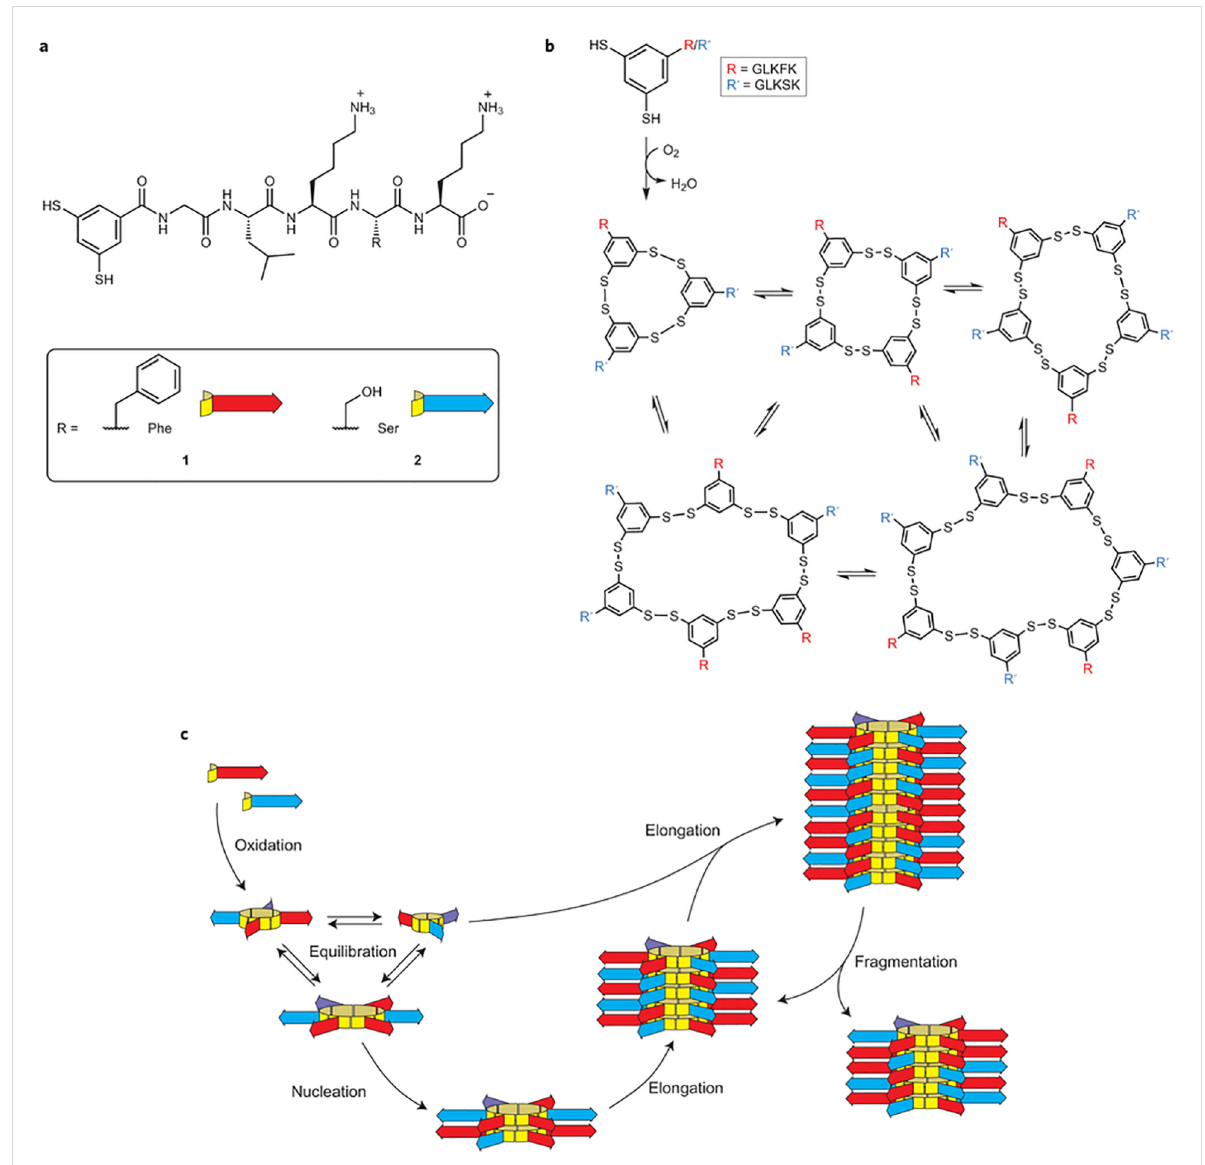
Figure 12: Figure depicting (a) building blocks consisting of a peptide attached to an aromatic ring. Building blocks 1 and 2 differ only in the nature of the penultimate amino acid. (b) The building blocks can form macrocycles of different sizes upon oxidation, which can exchange building blocks with each other. (c) Schematic representation showing how building blocks oxidize to form macrocycles that in turn form stacks due to β -sheet formation. Stacks grow from their ends and fragment upon agitation, leading to more fiber ends and faster growth [52].